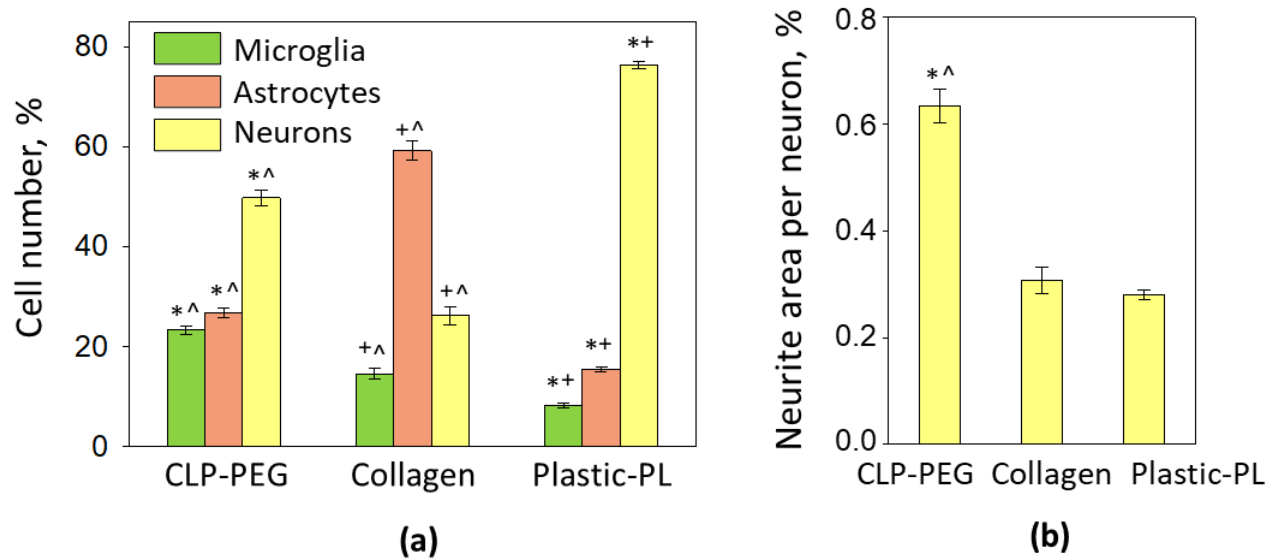
Figure 5. Cellular composition ( a ) and neuritogenesis ( b ) of cerebellar cell cultures on CLP-PEG and collagen hydrogels and poly- L -lysine (PL)-coated tissue culture plastic, respectively. For neurite evaluation, the MAP2-positive area in micrographs was measured by the ImageJ software and expressed as the percentage of the entire image area per single neuronal nucleus. The data are shown as averages of 3 – 6 experiments with standard error. * — denotes statistically significant difference compared to the collagen; ^ — compared to Plastic-PL; + — to CLP-PEG hydrogel; p < 0.01.